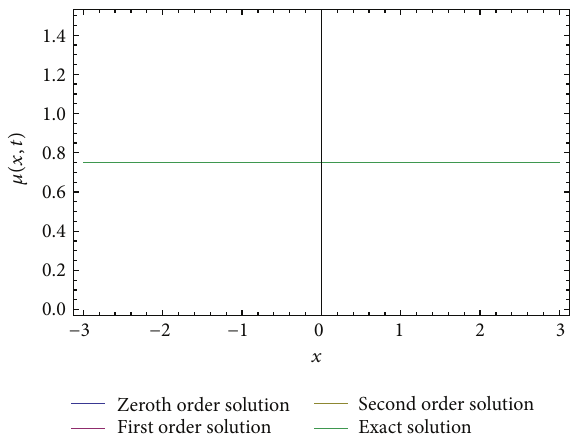
Figure 24: 2D, comparison of OHAM, VIM, HPM, and exact solutions for 𝜇(𝑥,𝑡) at 𝑡 = 0.1